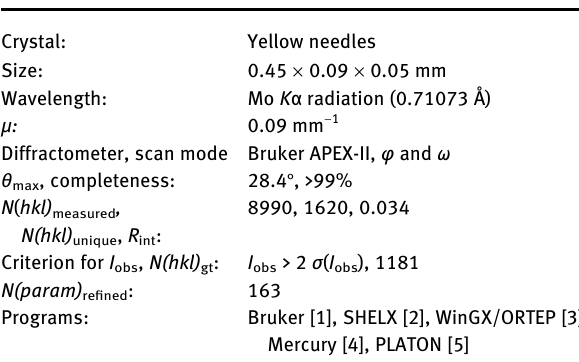
Table  : Data collection and handling.